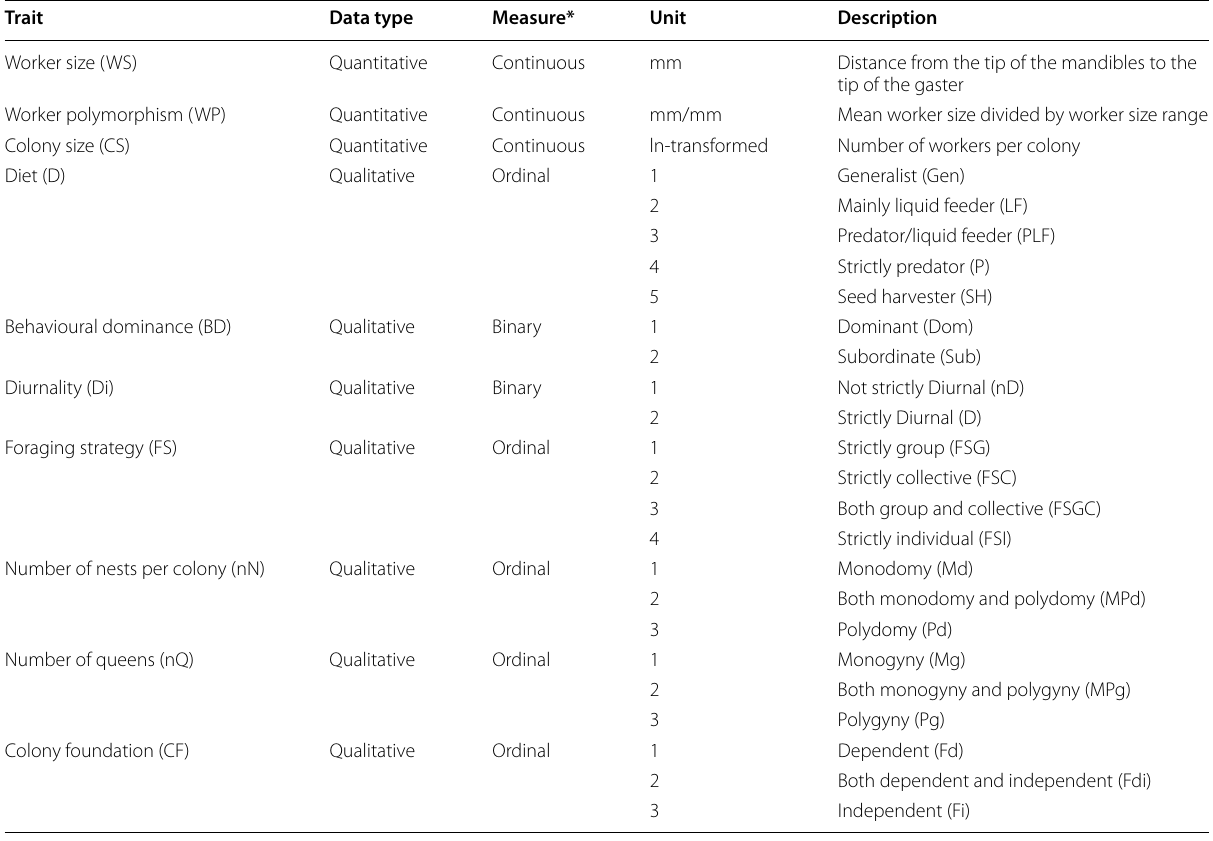
Table 2 List and description of the ant traits used in this study to analyse the response of ant communities to pastoral land use